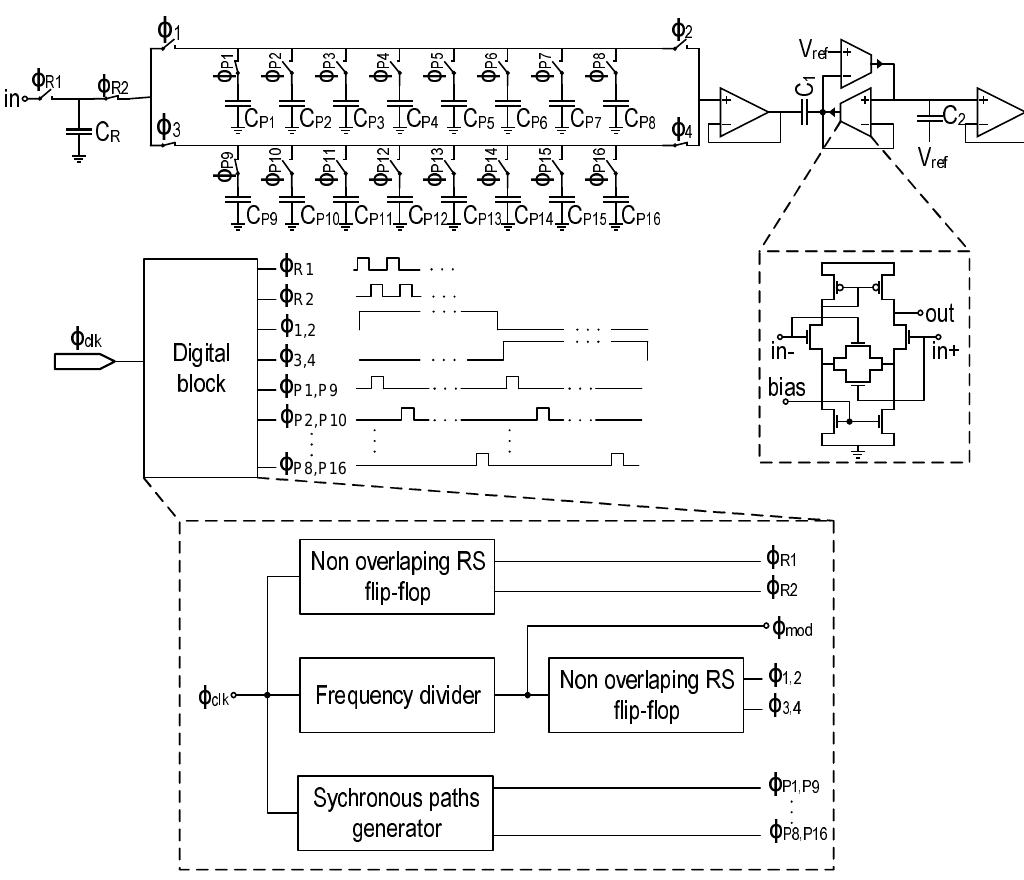
Figure 6. Schematic of the in-pixel high-Q